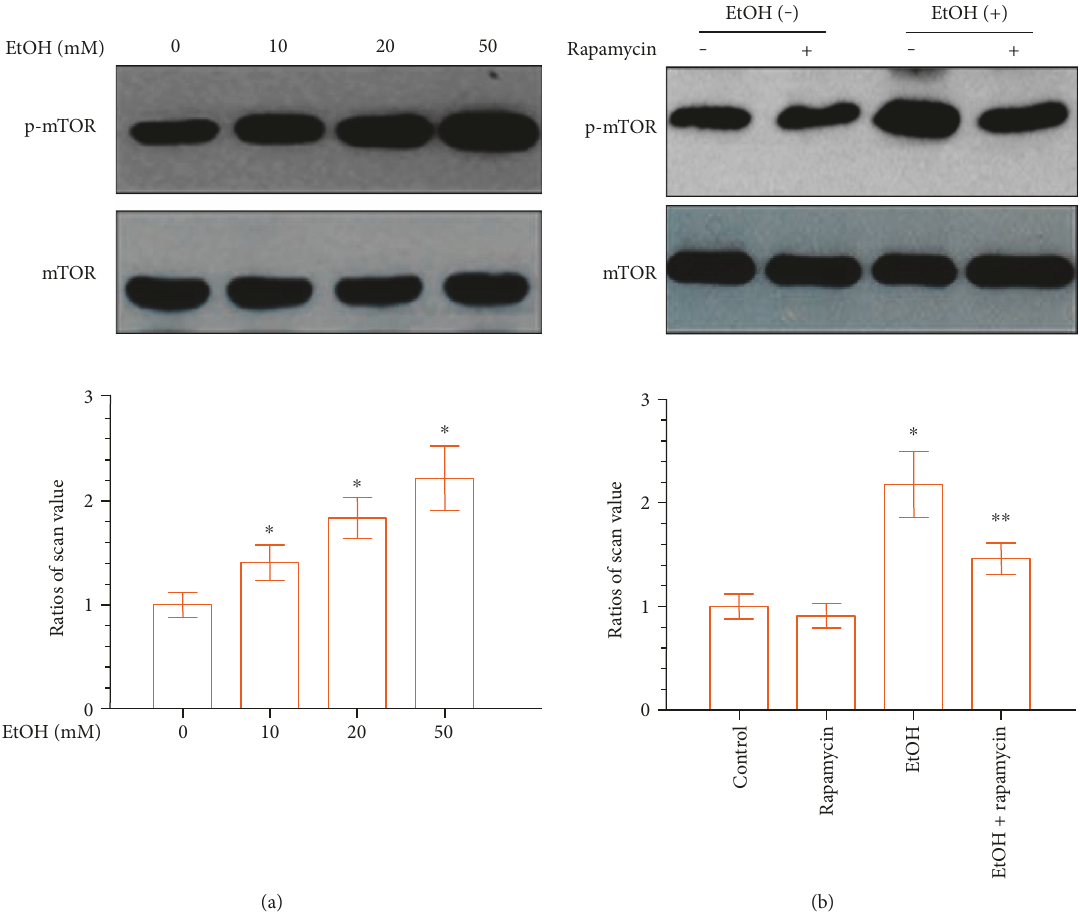
Figure 3: EtOH upregulates mTOR phosphorylation in DPCs in a dose-dependent manner. (a) DPCs were treated with di ff erent concentrations of EtOH for 24 hours. Lower panels show the ratios of band densities of phosphor-mTOR to mTOR. (b) Con fl uent DPCs cells were preincubated with the mTOR inhibitor rapamycin (50 mM) for 1 hour before treatment with EtOH. Rapamycin decreases EtOH-induced mTOR phosphorylation. Data represent mean ± SD of 3 experiments with triplicates. ∗ p < 0 05 versus control group. ∗∗ p < 0 05 versus EtOH